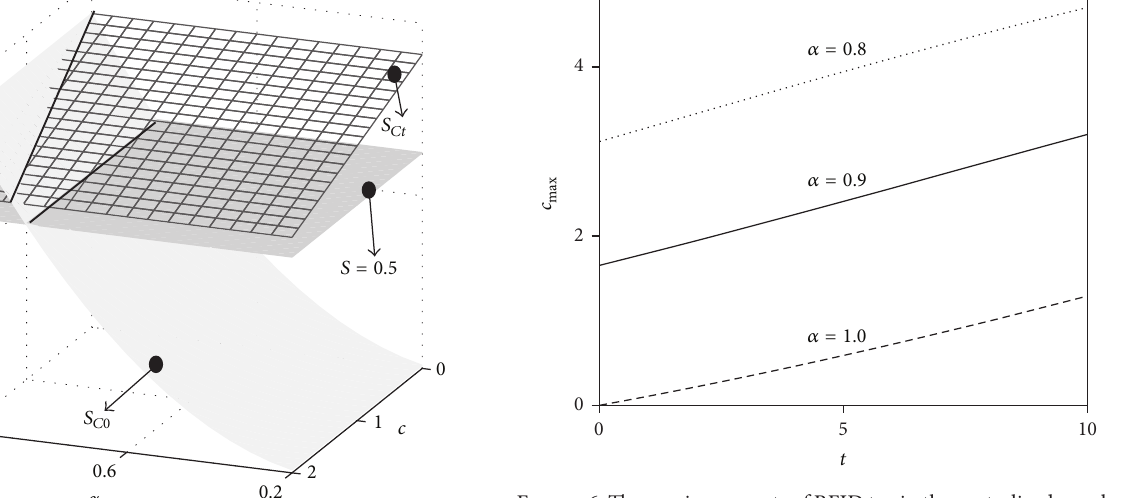
Figure 6: The maximum costs of RFID tag in the centralized supply chain.